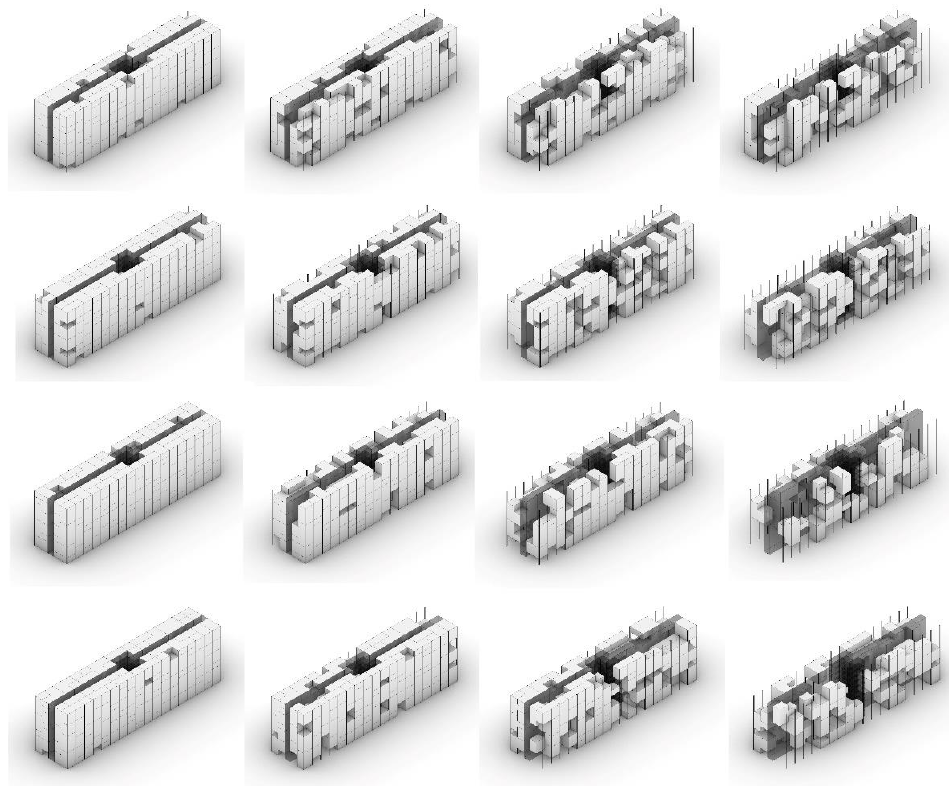
Figure 8. Programming results showing alternatives of modules distributions of housing units, in- cluding open spaces (Source: authors).